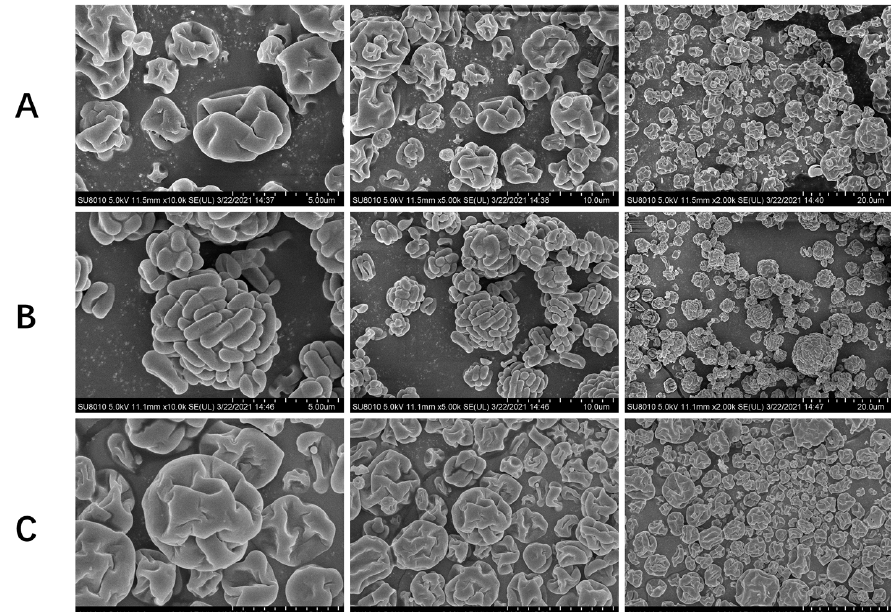
Figure 4. Scanning electron microscopy (SEM) images of microcapsules coated with different wall materials. ( A ) Skim milk/sodium glutamate/polyvinylpyrrolidone/maltodextrin/gelatin microcapsules. ( B ) Skim milk/sucrose/glycerol/glycine microcapsules. ( C ) Trehalose/skim milk/maltodextrin microcapsules.